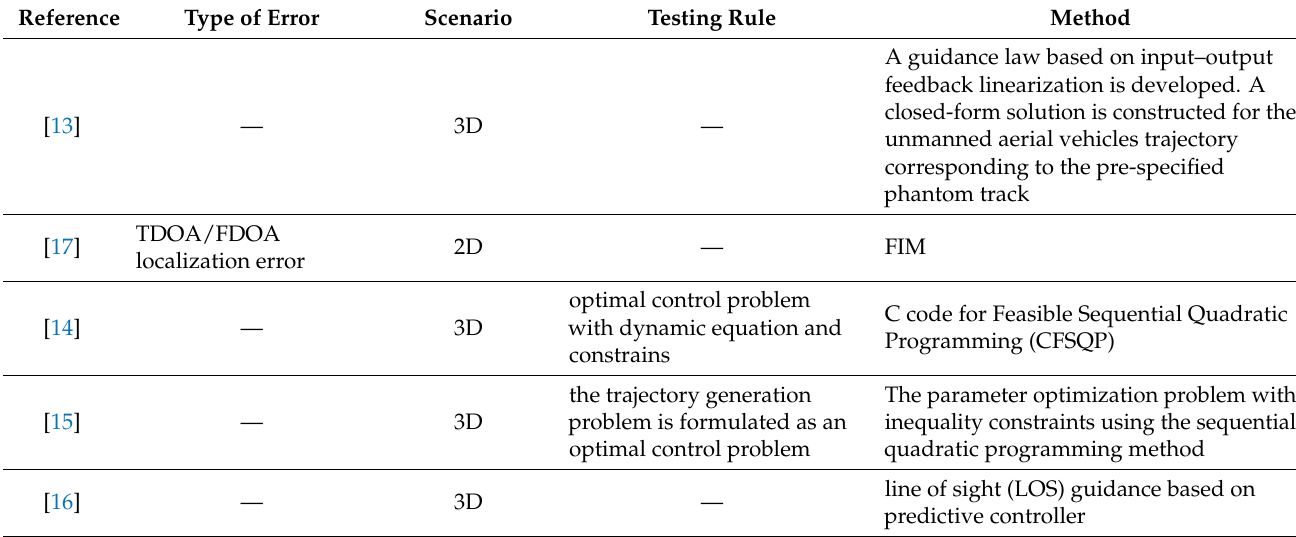
Table 2. Related work by Korean